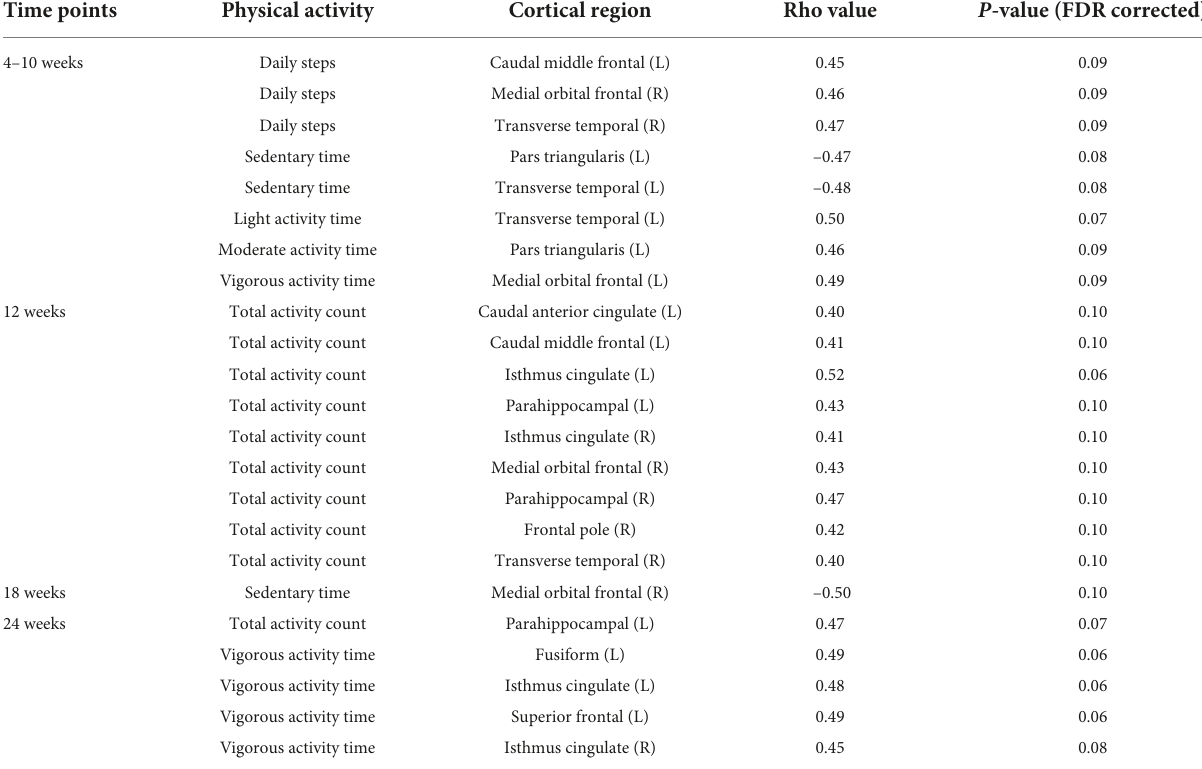
TABLE 2 Additional relationships between mother’s physical activity and newborn’s brain cortical thickness at a level of FDR corrected P -values between 0.05 and 0.10. Time